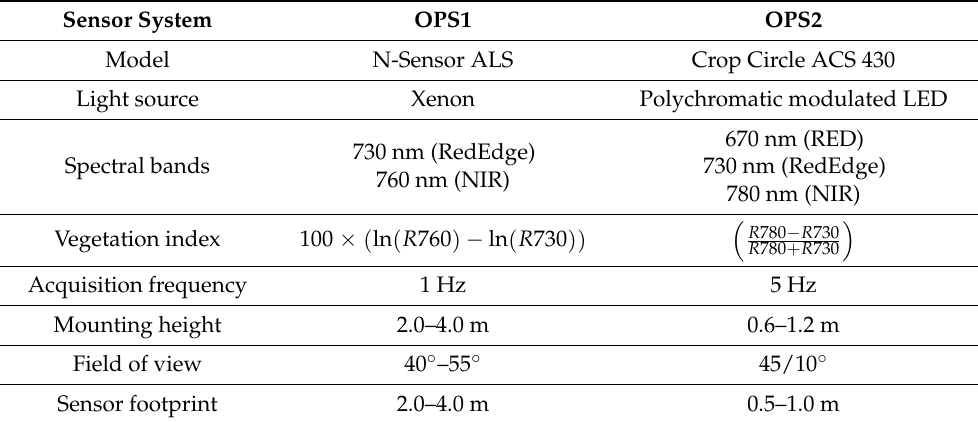
Table 2. Technical specifications of crop canopy optical sensors evaluated in cotton fields.